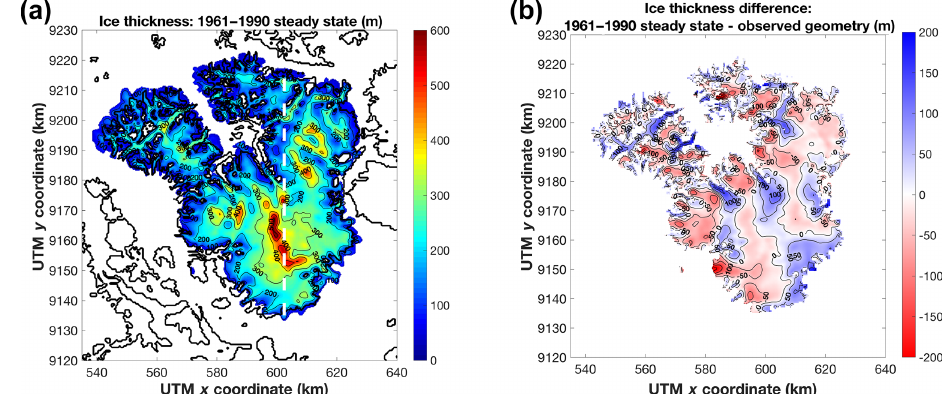
Figure 5. (a) 1961–1990 steady-state ice thickness from the HO 250m resolution run. The thick black lines represent the outlines from the glaciated areas from the DEM (Starzer and Reeh, 2001). The dotted white line is the transect at UTM x = 602.5km that is illustrated in Fig. 11. (b) Ice thickness difference between the 1961–1990 modelled steady-state geometry and the observed